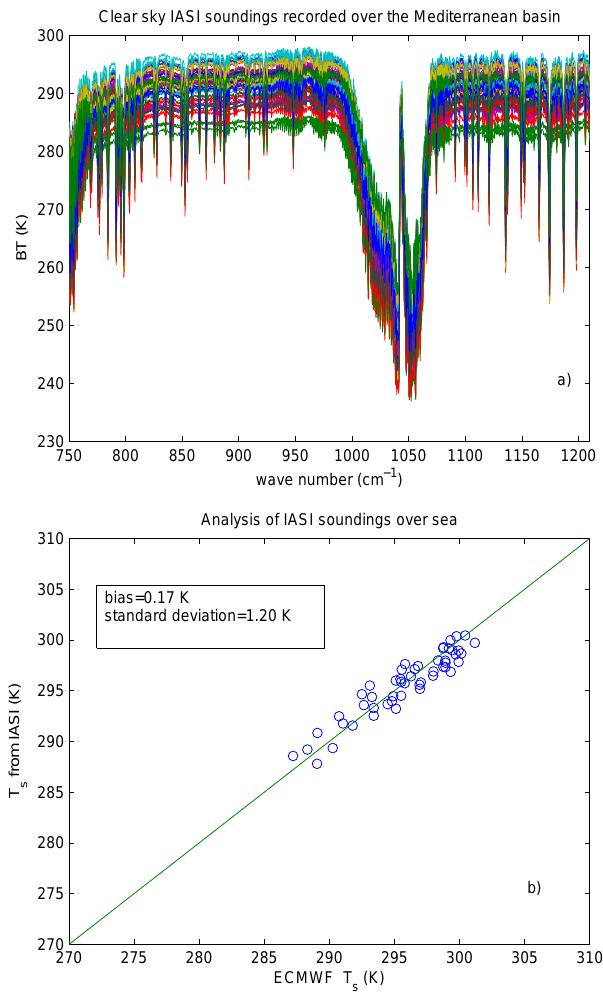
Figure 1. Example of the performance of the split window tech- Fig. 1. Example of the performance of the split window technique nique for the estimation of the skin temperature. Panel (b) compares for the estimation of the skin temperature. Panel b) compares the the IASI T s obtained from the spectra shown in (a) with the time– space co-located ECMWF IASI T obtained from the spectra shown in a) with the time-space s co-located ECMWF analysis.